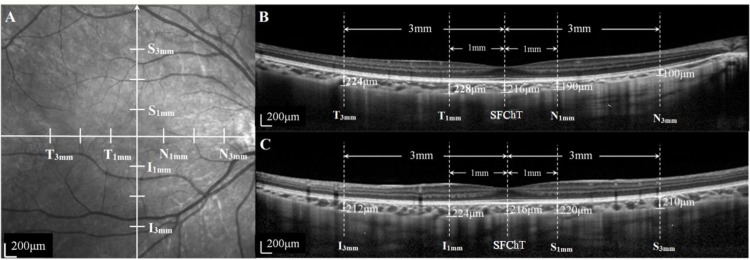
Illustration of choroidal thickness (ChT) measurements in the fundus.(A) Fundus image showing horizontal and vertical scan lines going through the fovea. Choroidal thicknesses at 1 and 3 mm to the fovea superiorly, inferiorly, temporally, and nasally are marked as S1mm, I1mm, T1mm, N1mm, S3mm, I3mm, T3mm, and N3mm, respectively. (B) OCT image with horizontal scan. Left: temporal; right: nasal. OCT image shows SFChT, T1mm, N1mm, T3mm, and N3mm. (C) OCT image with vertical scan. Left: inferior; right: superior. OCT image shows SFChT, S1mm, I1mm, S3mm, and I3mm. Short horizontal lines in each dash-line in (B) and (C) indicate the borders measured for the choroid, and each figure indicates individual ChT in different locations.